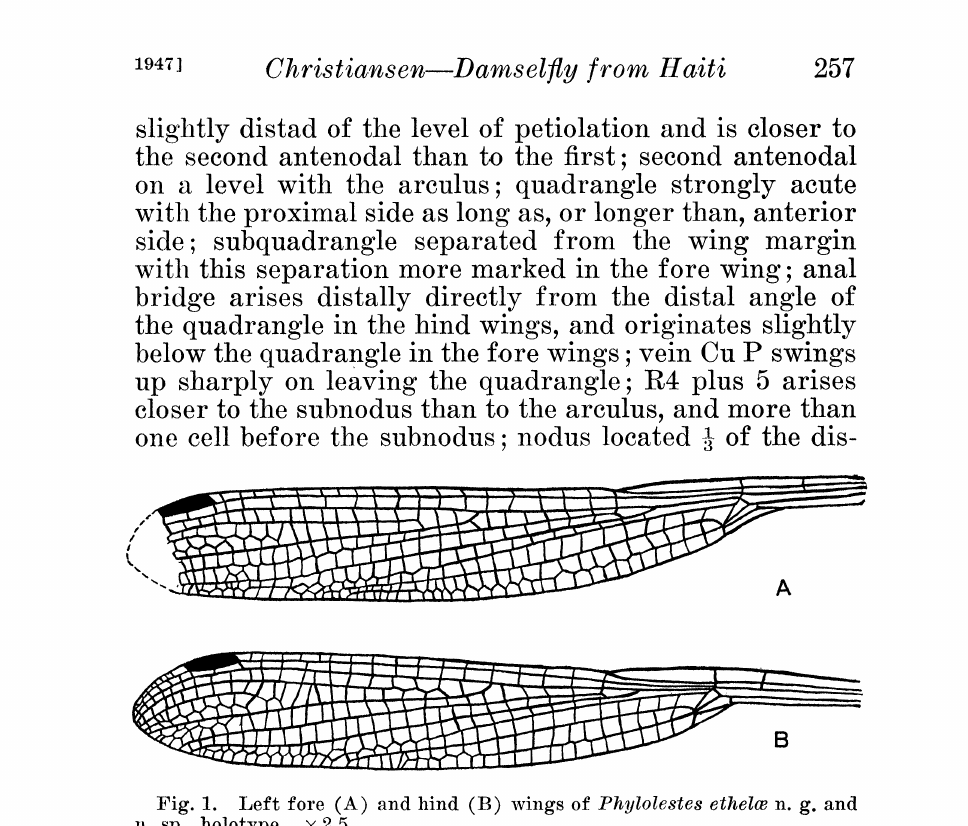
Fig. 1. Left fore (A) and hind (B) wings of Phylolestes ethelce n. g. and I. sp., holotypc.